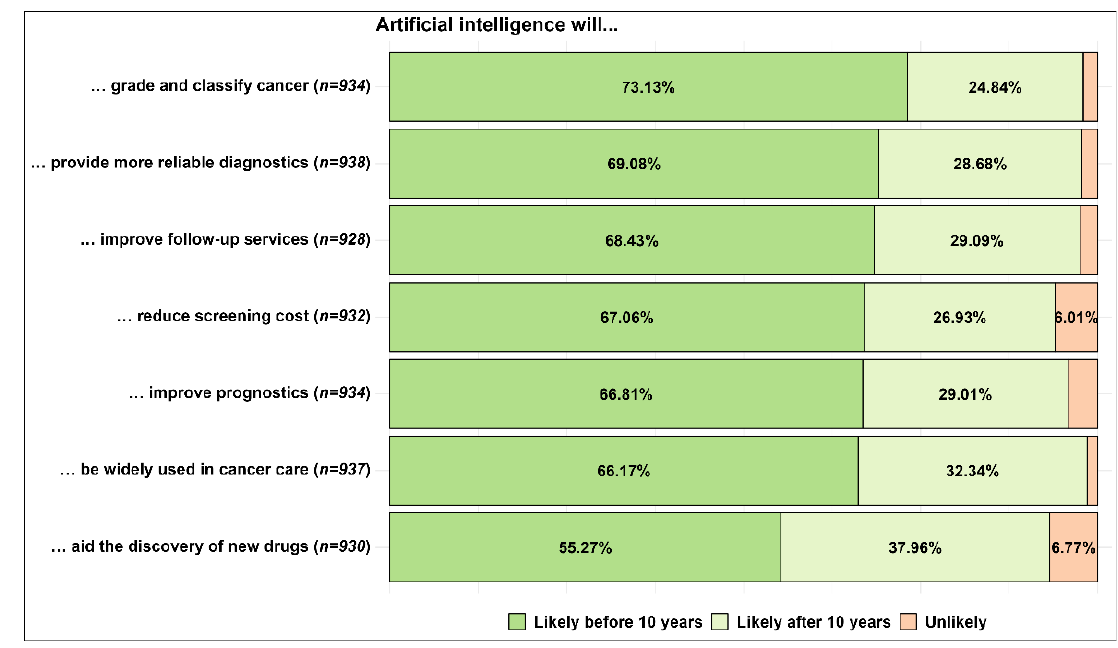
Figure 2. Likelihood of expected future events derived from the use of AI in cancer care.